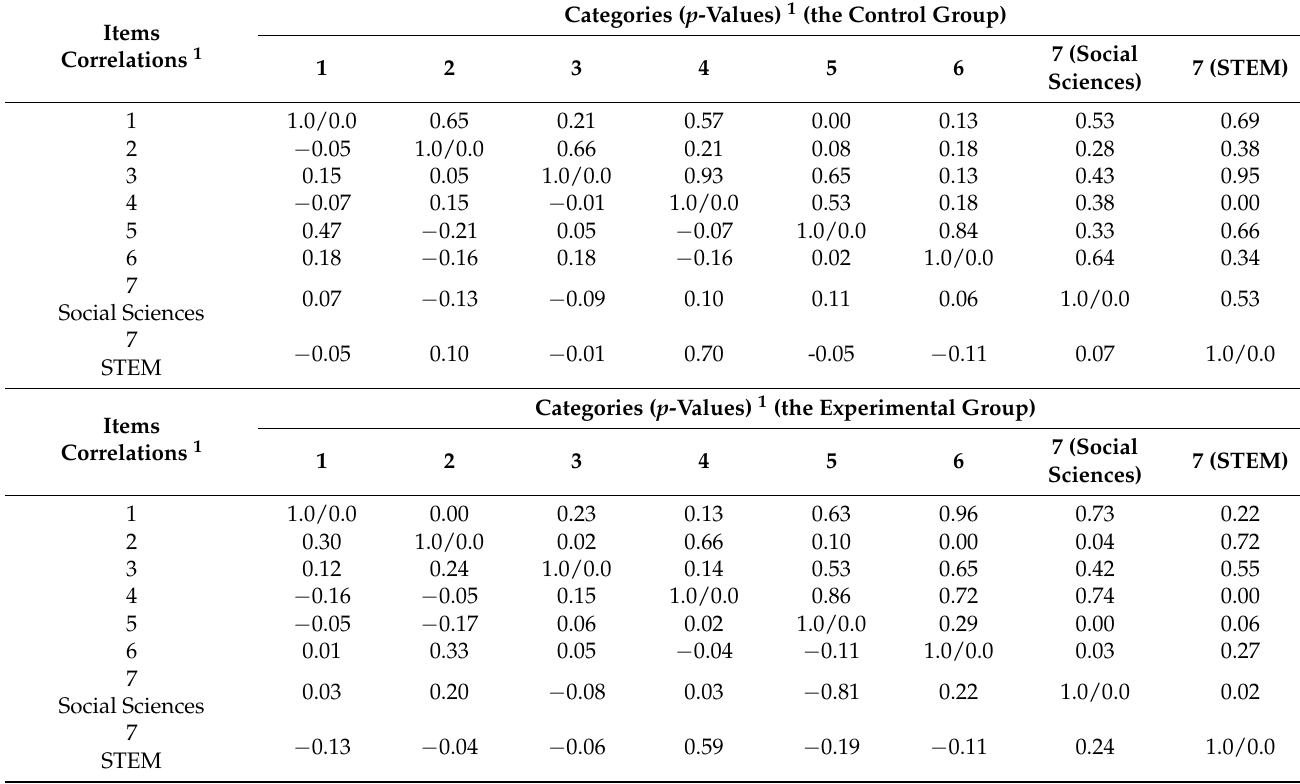
1 Correlations (bright orange color) and p -values (blue color) has been colored to show the nature of the results the table